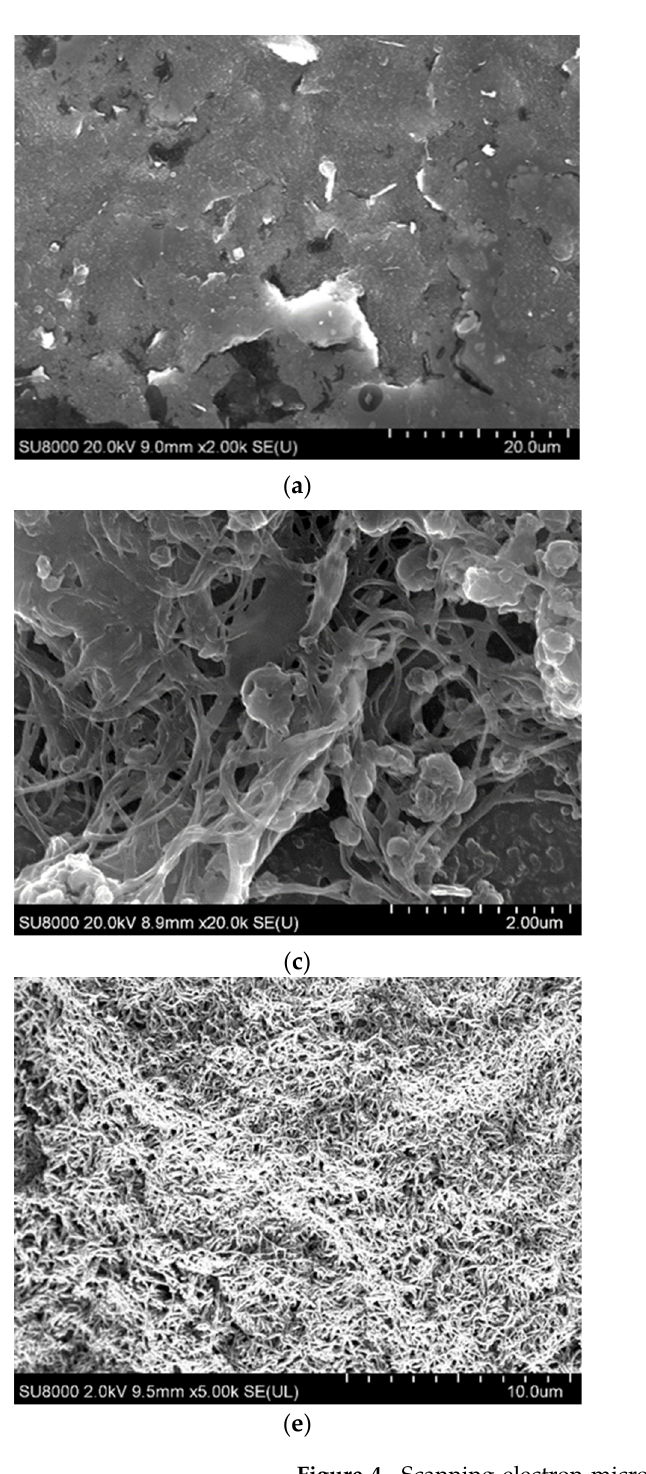
greatly facilitates the transfer of electrons from the enzyme to the electrode (Figure 4b,c).